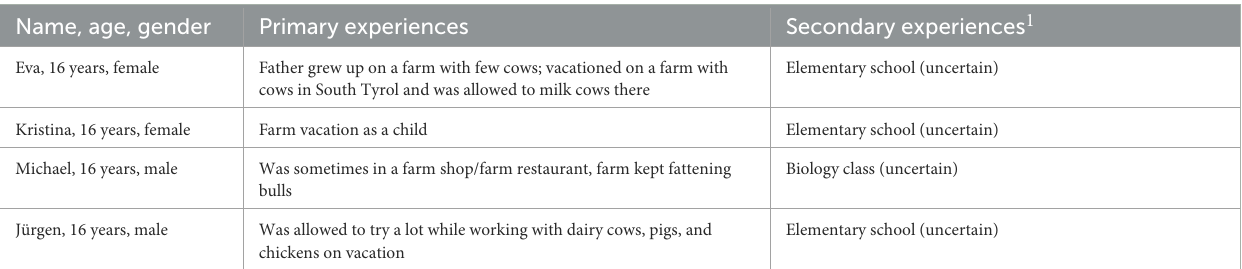
TABLE 2 Overview of tenth-grade